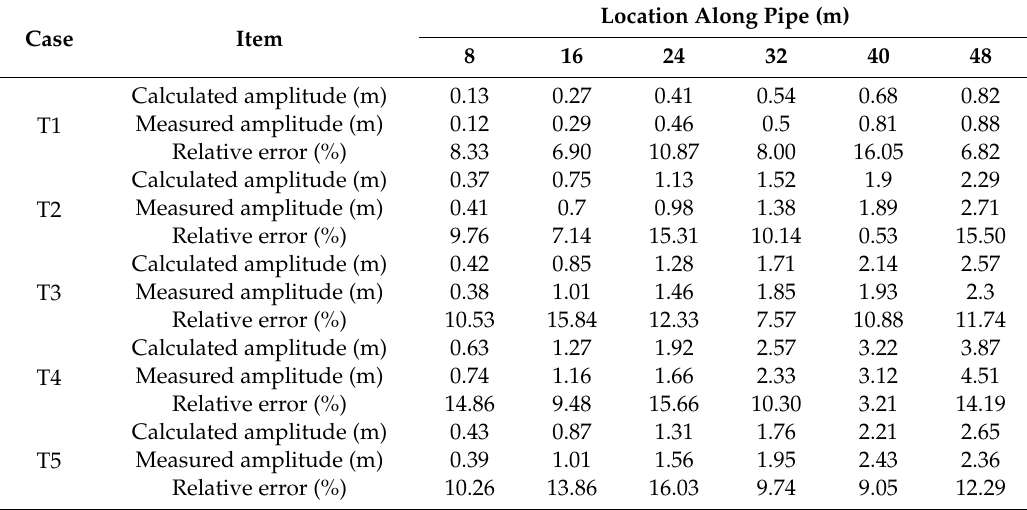
Table 7. The measured and calculated amplitudes of the pressure head loss along the pipe for Cases T1, T2, T3, T4, and T5.